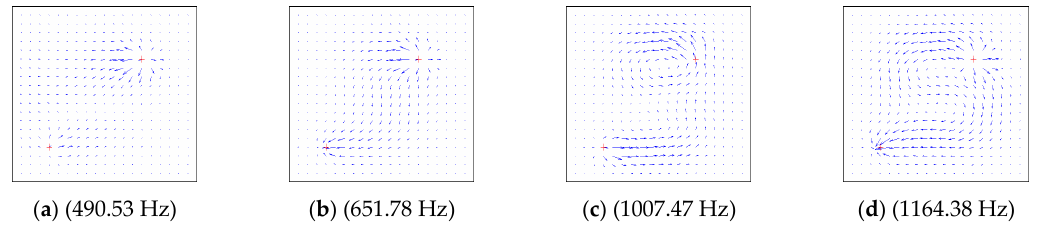
Figure 17. The power flow field for a CSSS lamitated plate excited by point force on (0.2 m, 0.2 m) and (0.7 m, 0.7 m). ( a ) (490.53 Hz), ( b ) (651.78 Hz), ( c ) (1007.47 Hz), ( d ) (1164.38 Hz).